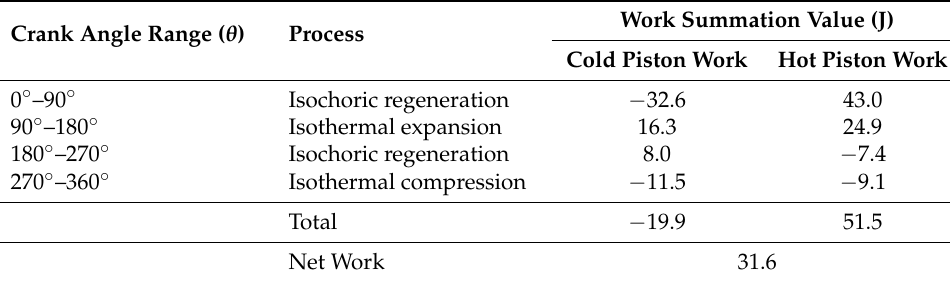
Figure 4. Work in the ( a ) hot cylinder and ( b ) cold cylinder versus crank angle ( θ ) for the alpha-type Stirling engine. The W out corresponds to Q in and is shown as red, and the W in corresponds to Q out and is shown as blue. Table 2. Summary of work during each process for the alpha-type Stirling